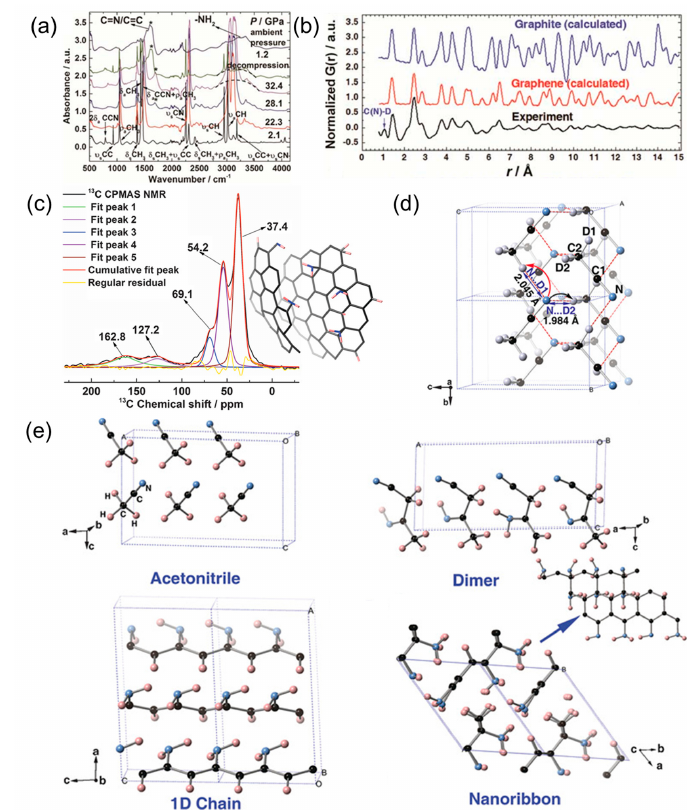
Figure 10. ( a ) In situ IR spectrum of CH 3 CN during compression and decompression [120]. ( b ) Experimental PDF (G(r)) of D-graphitic polymer recovered from 25 GPa and modeled PDF (G(r)) of graphite and graphene models [120]. ( c ) 13 C CPMAS ssNMR spectrum of graphite polymer. ( d ) Crystal structure of CD 3 CN at 20.6 GPa [120]. ( e ) The possible reaction process of acetonitrile under high pressure indicated by metadynamic calculations at 35 GPa [120].